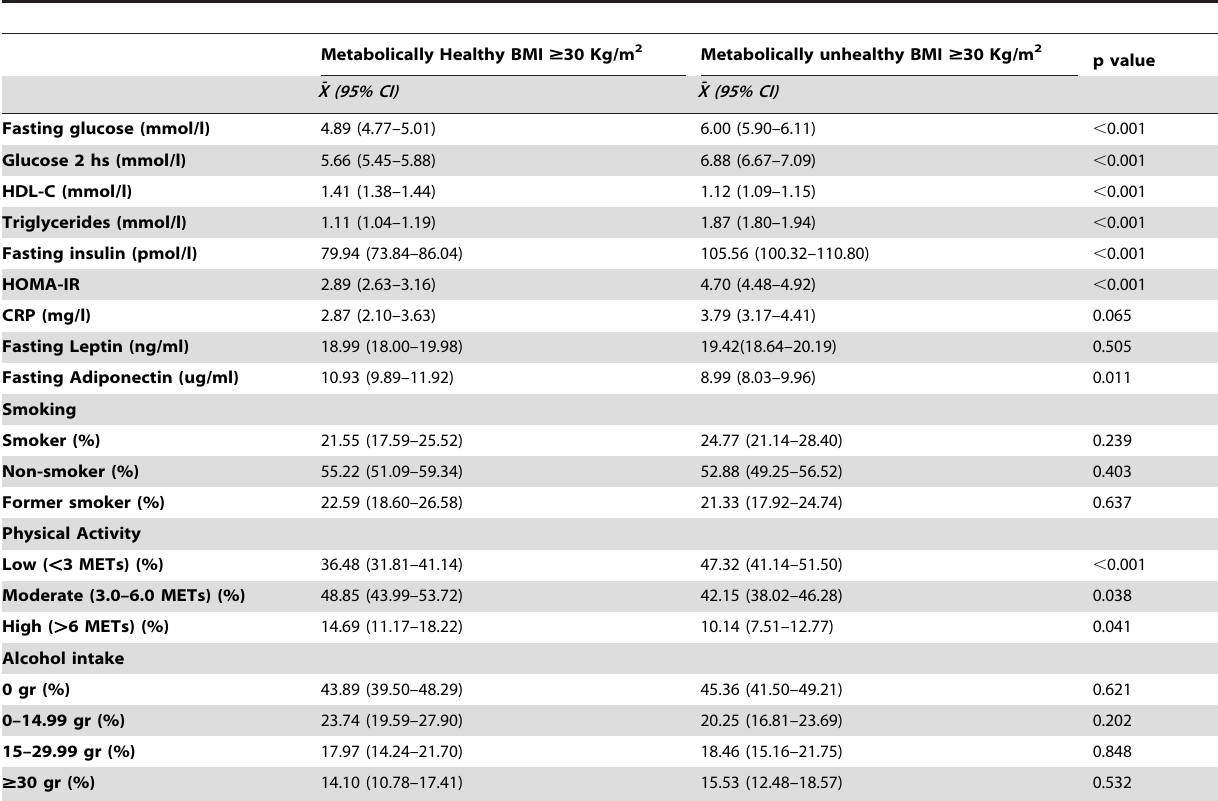
Table 7. Biochemical characteristics and lifestyle in individuals metabolically healthy and unhealthy with BMI $ 30 kg/m 2 by Consensus Societies criteria, adjustment by age and sex.